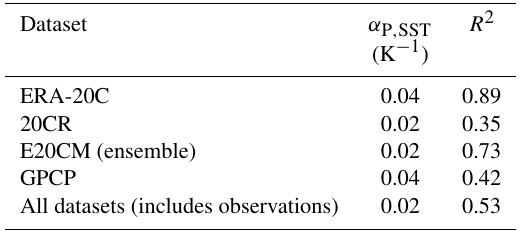
Table 3. Linear regression coefficient α P , SST estimated from (cid:49)PP c against (cid:49) SST at 2-year resolution. The respective coeffi- cients of determination are also provided. The α P , SST values are computed for ERA-20C, 20CR, for the ensemble of ERA-20CM simulations, and for GPCP against ERA-20CM control SST forc- ing. Additionally, the coefficient is estimated by pooling together all